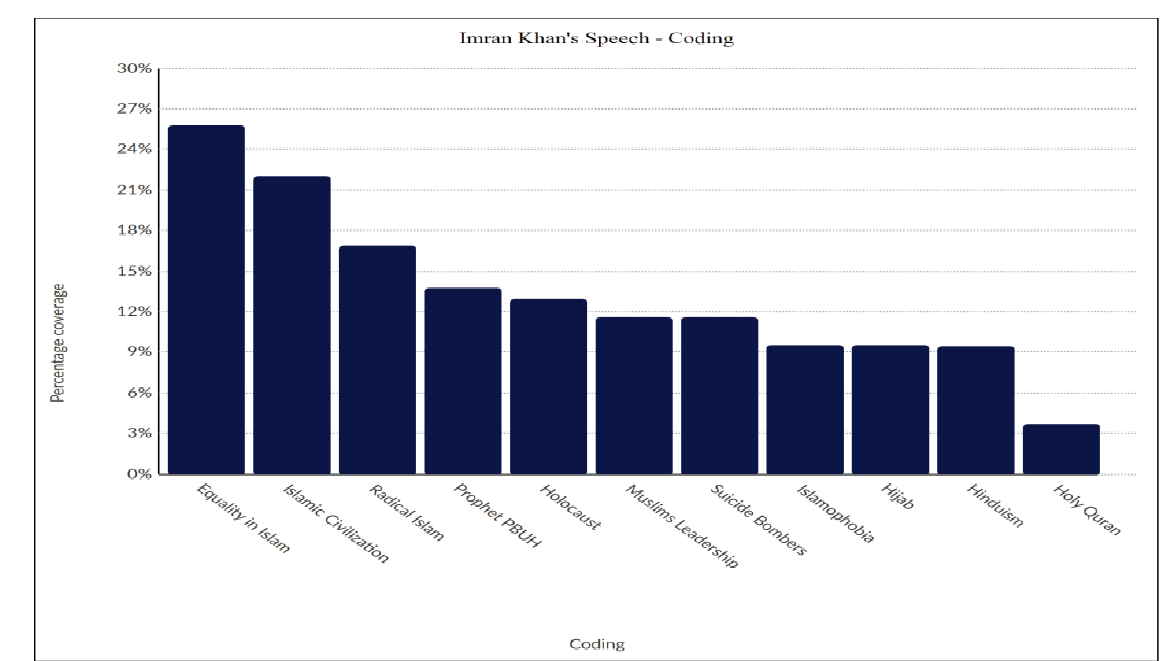
Figure 2. Coding of frequently used words.